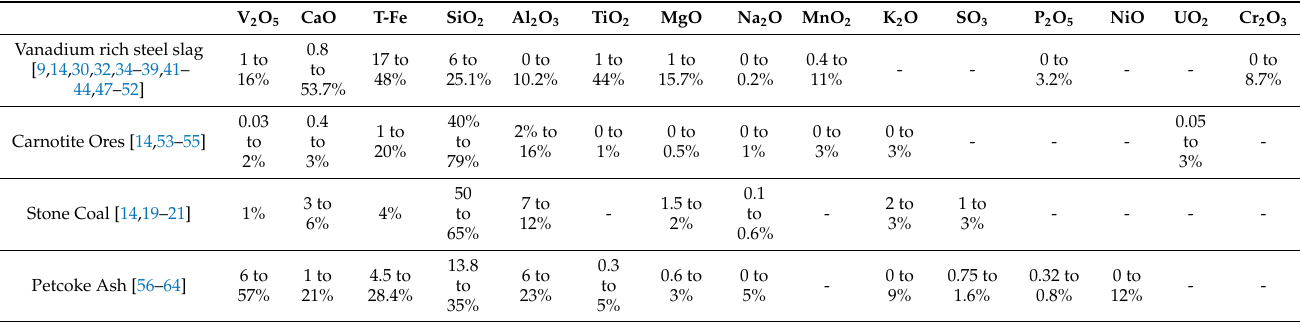
Table 1. Range of composition of major vanadium feedstocks.